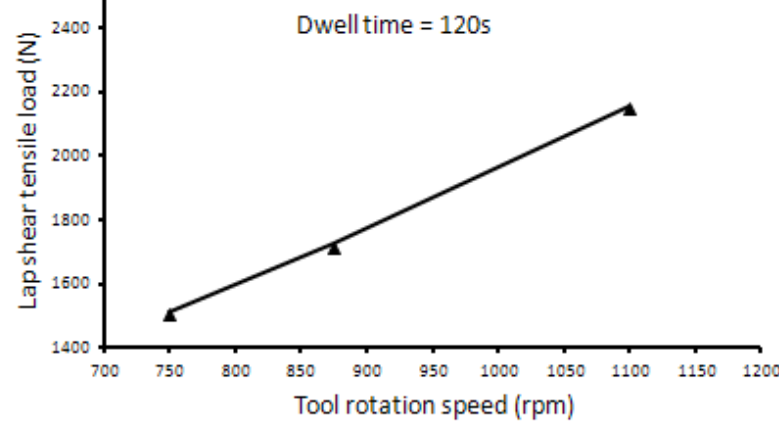
Figure 9: Tool rotation speed